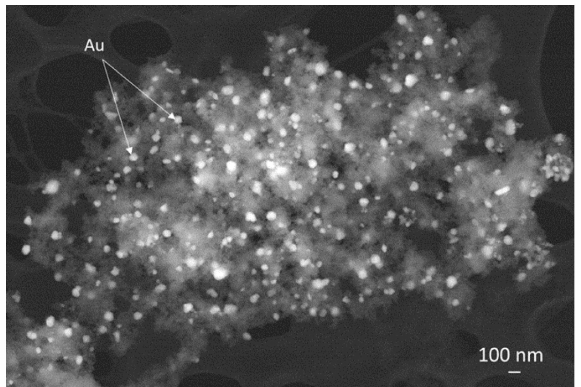
Figure 5. STEM analysis of magnetite nanoparticles decorated with Au nanoparticles using tannic acid as reducing